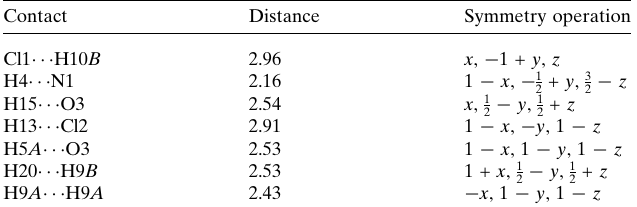
Table 1 Hydrogen-bond geometry (A˚ , (cid:3) ).